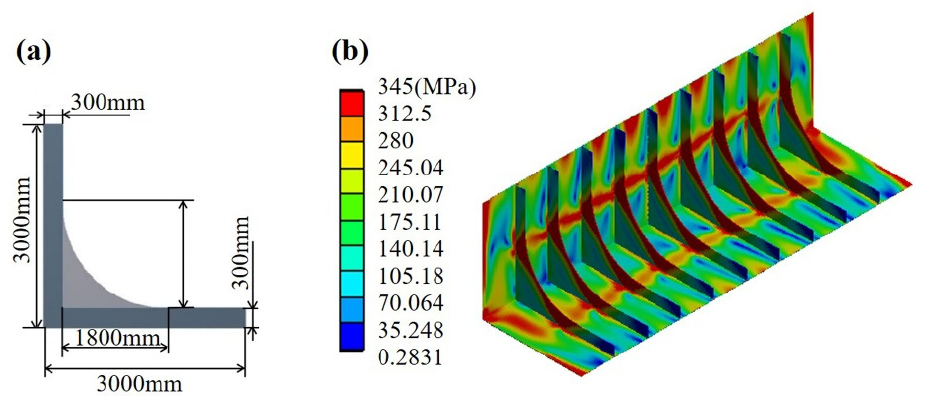
Figure 6. Contours of the von Mises stress distribution of connected plates reinforced with rib form 2: ( a ) rib form 2; ( b ) contours of the von Mises stress distribution.